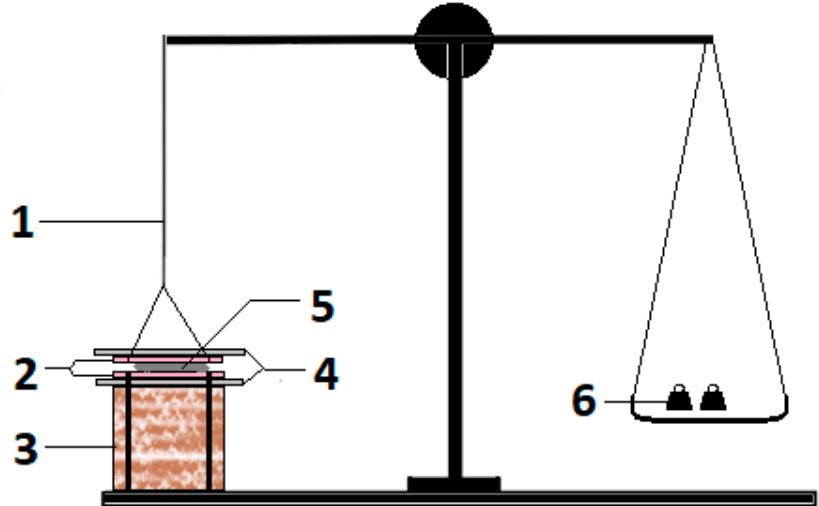
Figure 10. Modified physical balance for estimating ex vivo mucoadhesive strength of buccal gels [65], where 1 = arm replaced with thread, 2 = adhesive buccal mucosa on fixed and movable glass slides, 3 = fixed base, 4 = upper movable (with thread) and lower fixed (with base) glass slide, 5 = gel sample, and 6 = weights added to estimate mucoadhesive strength.